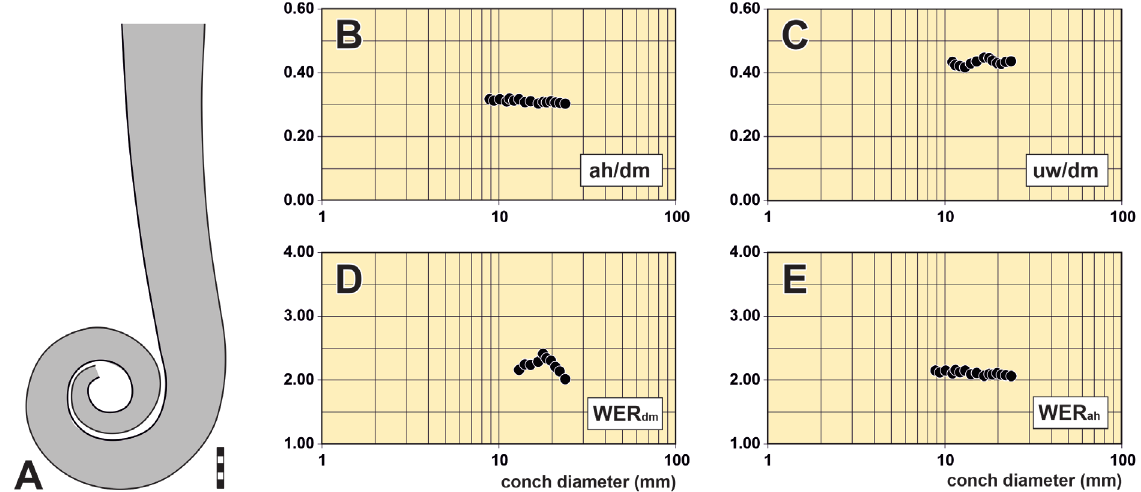
Fig. 61. Lituites nebeni sp. nov. A . Outline of coiled conch part of holotype MB.C.30541 (Neben Coll.). B–E . Conch proportions and coiling rates of holotype MB.C. MB.C.30541. Scale bar units = 1